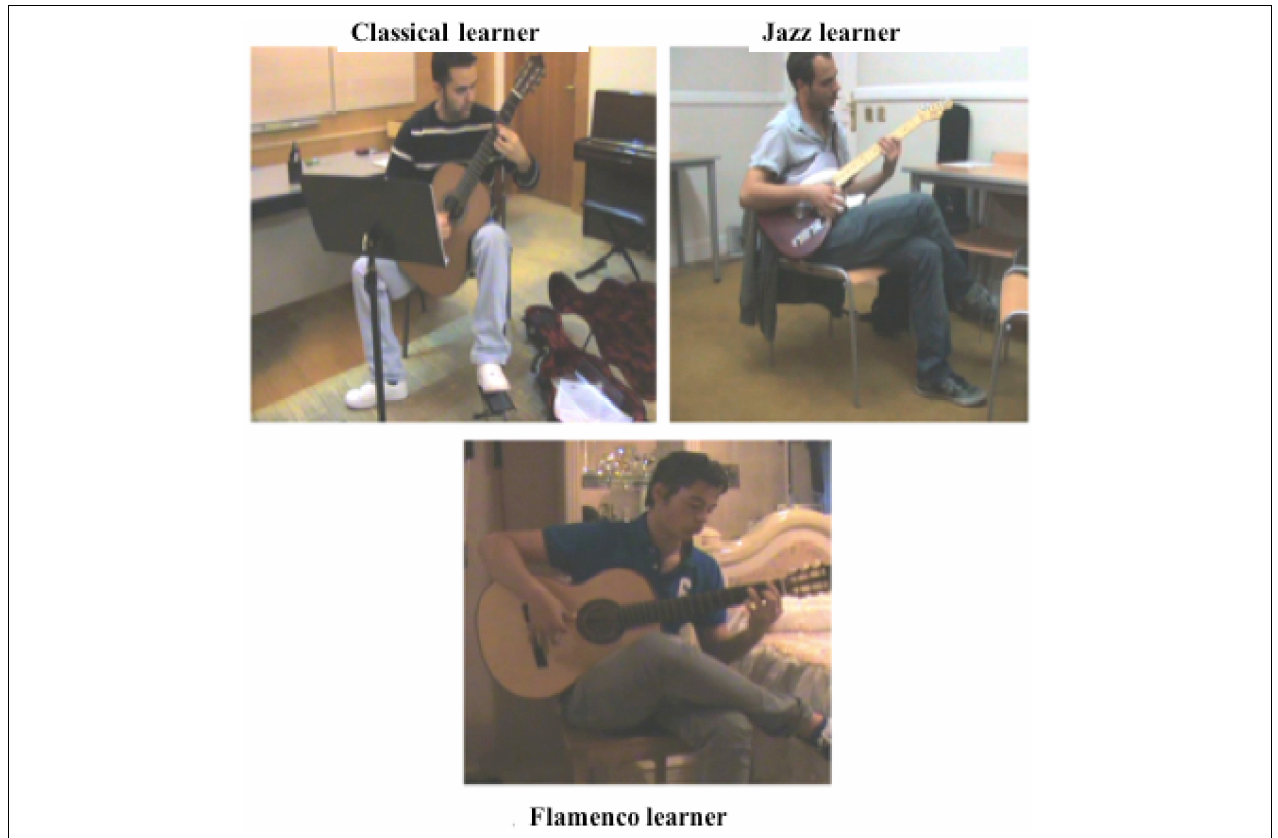
FIGURE 1 | Learner posture during practice in three learning cultures.